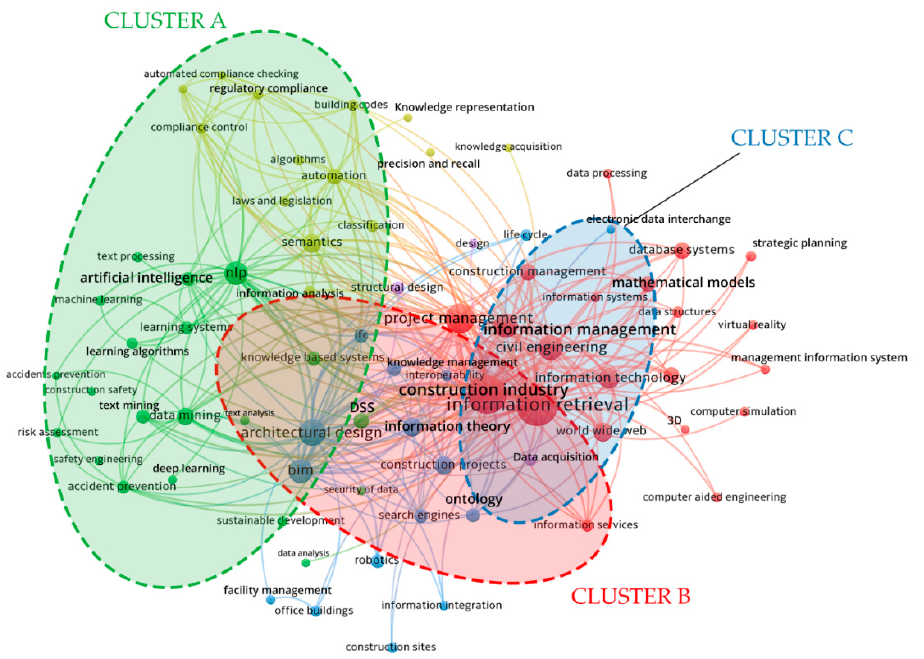
Figure 12. Overlay of factorial map clusters on the co-occurrence network. Software: VosViewer version 1.6.15.